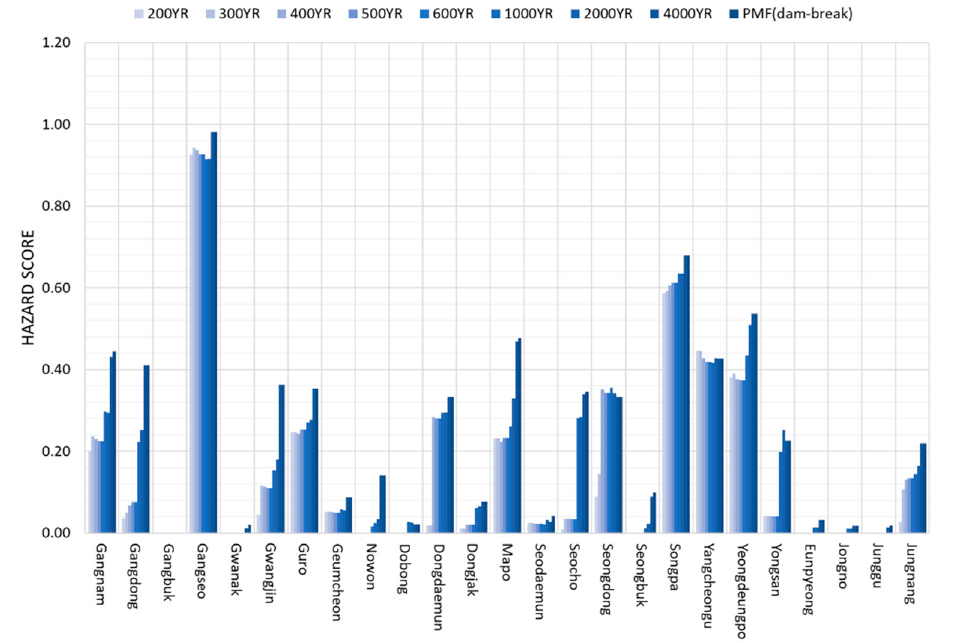
Figure 13. Flood hazard score considering casualties (bar graph).